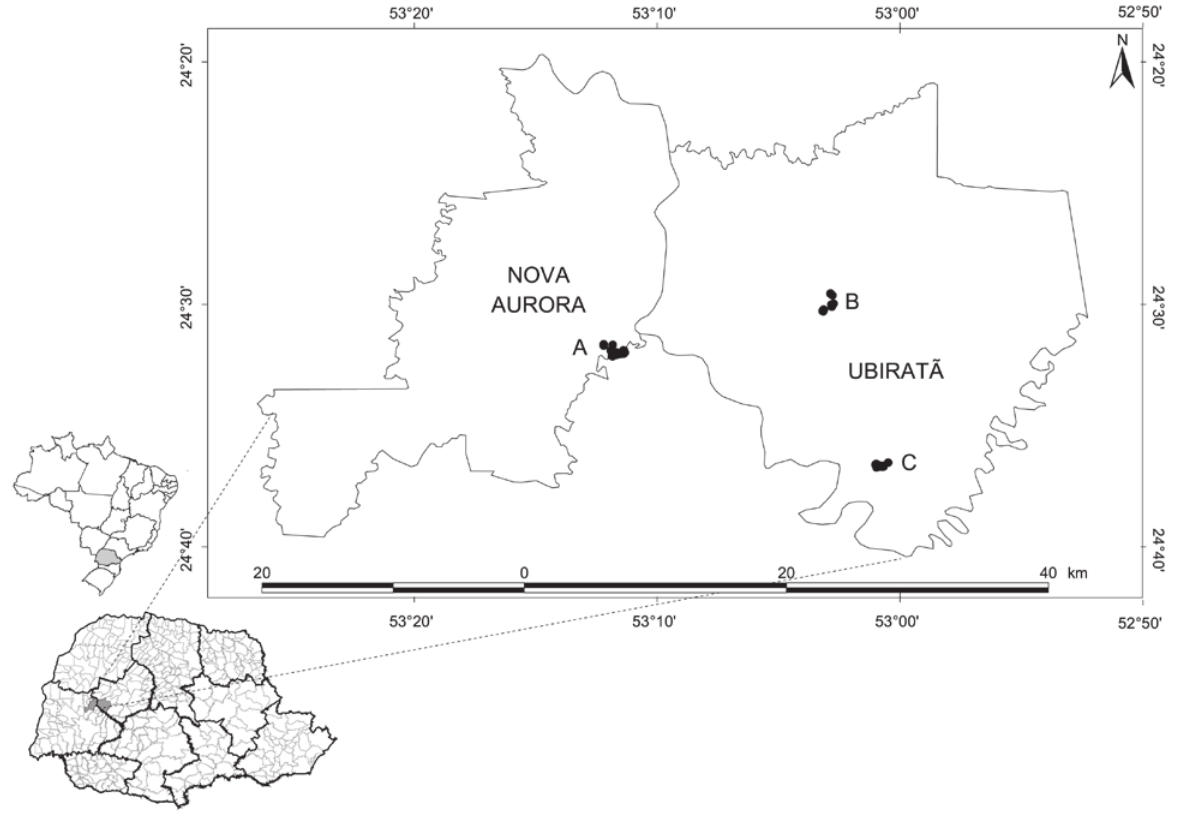
Figure 1 - Location of the collection points in the counties of Nova Aurora (Point A) and Ubiratã (Points B and C) in Paraná